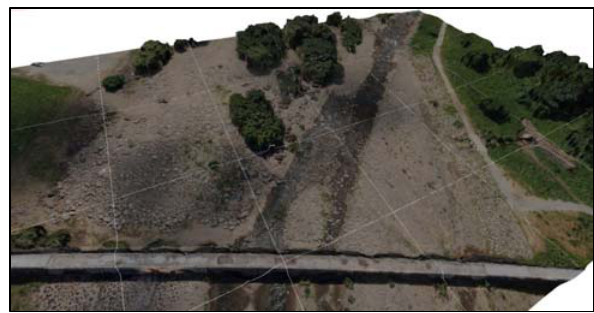
Figure 18. DSM generated with images from UAV Moreover, we generated a colored DEM with a ground resolution of 5 cm from point cloud acquired with the terrestrial laser scanner. As shown in Figure 19, several missing areas exist in the DEM due to laser reflection problems. Thus, we applied the PatchMatch to the colored DEM from the laser scanning data. We have confirmed that missing areas were reconstructed as well as an aerial image, as shown in Figure 20.